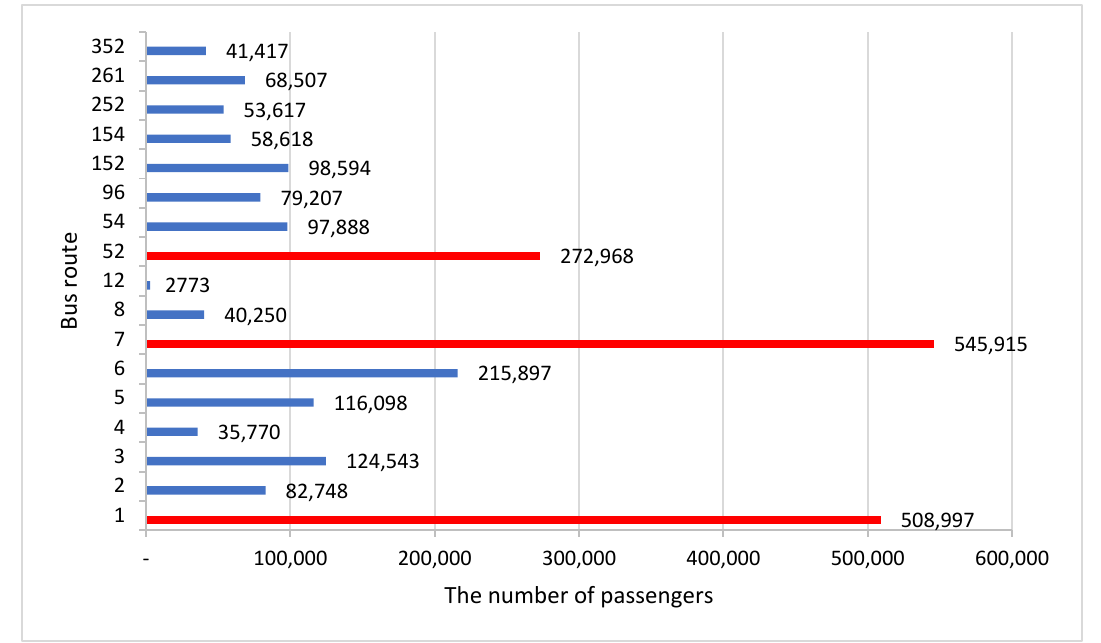
Figure 2. The number of passengers for each route.